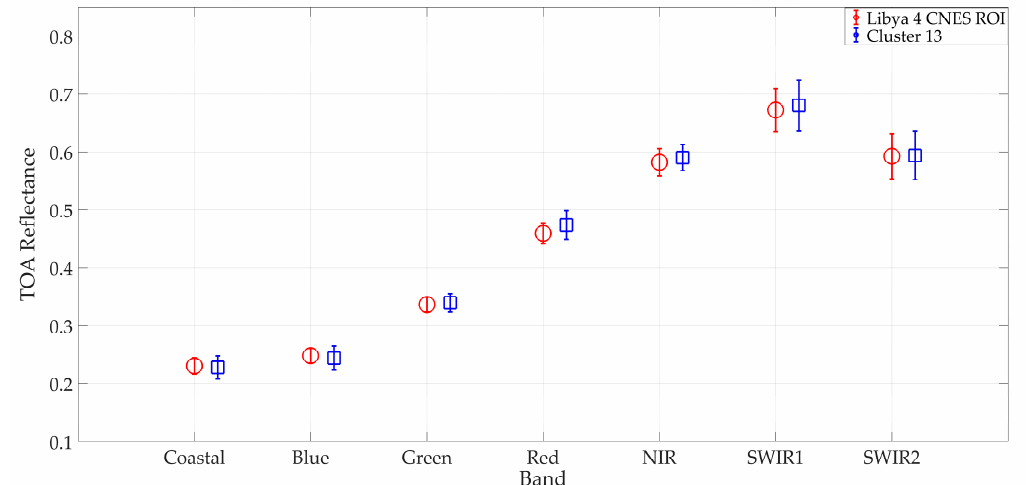
Figure 7. Comparison between the temporal mean and its standard deviation between traditional PICS (Libya 4 CNES ROI) and Cluster 13. Red and Blue symbols represent the temporal mean of Libya 4 CNES ROI and Cluster 13 respectively.